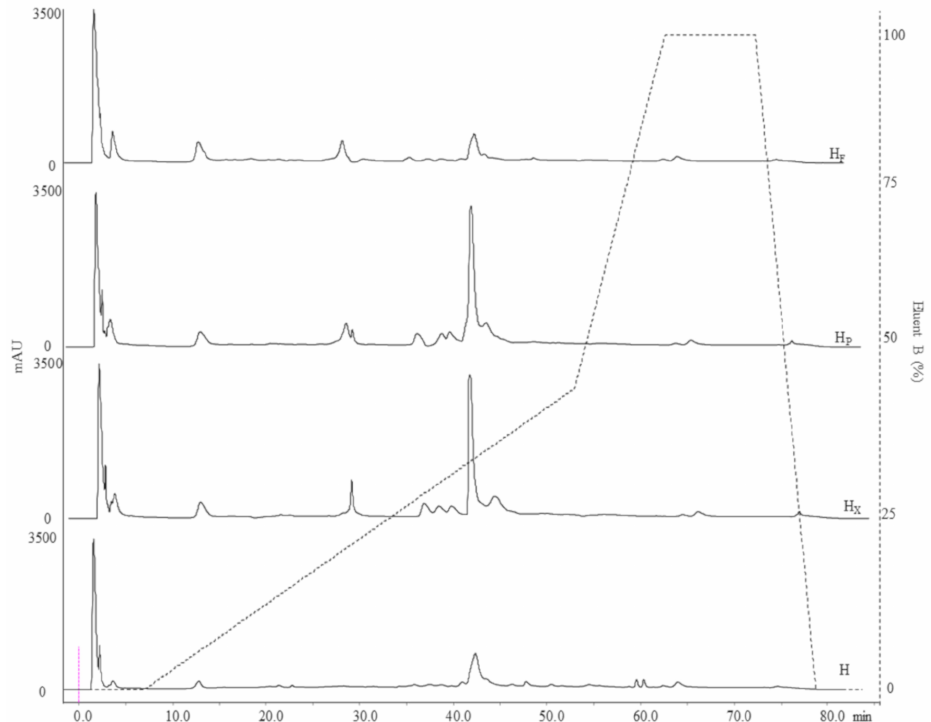
Figure 2. Peptide profiles of raw and bioprocessed hemp obtained by RP-FPLC (detector at 214 nm). Dashed line refers to the eluent B gradient. H, untreated hemp dough; H X , hemp dough treated with xylanase Depol 761P (1% wt / wt of fiber); H P , hemp dough treated with protease VeronPS (2.5% wt / wt of protein); H F , hemp dough fermented by Lactiplantibacillus plantarum 18S and Leuconostoc mesenteroides 12MM1 (ratio 1:1, final cell density of circa 7 log10 cfu / g). All treated samples were incubated at 30 ◦ C for 24